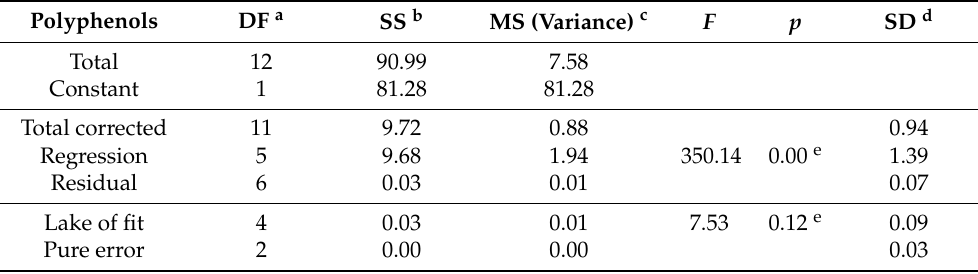
Table 3. Analysis of variance for the model in the extraction of polyphenols from blackcurrant (a) Degrees of freedom; (b) sum of squares; (c) mean square; (d) standard deviation; (e) p ≤ 0.05 .